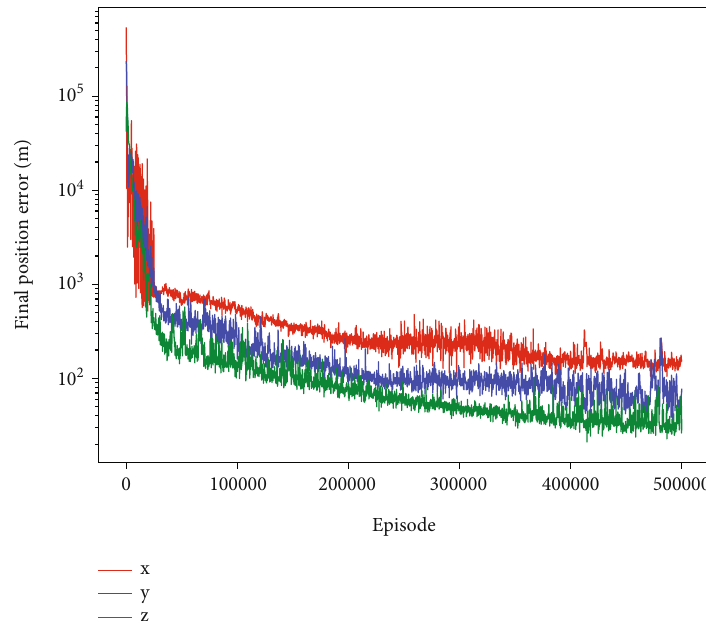
Figure 3: Learning curves for fi nal position error.